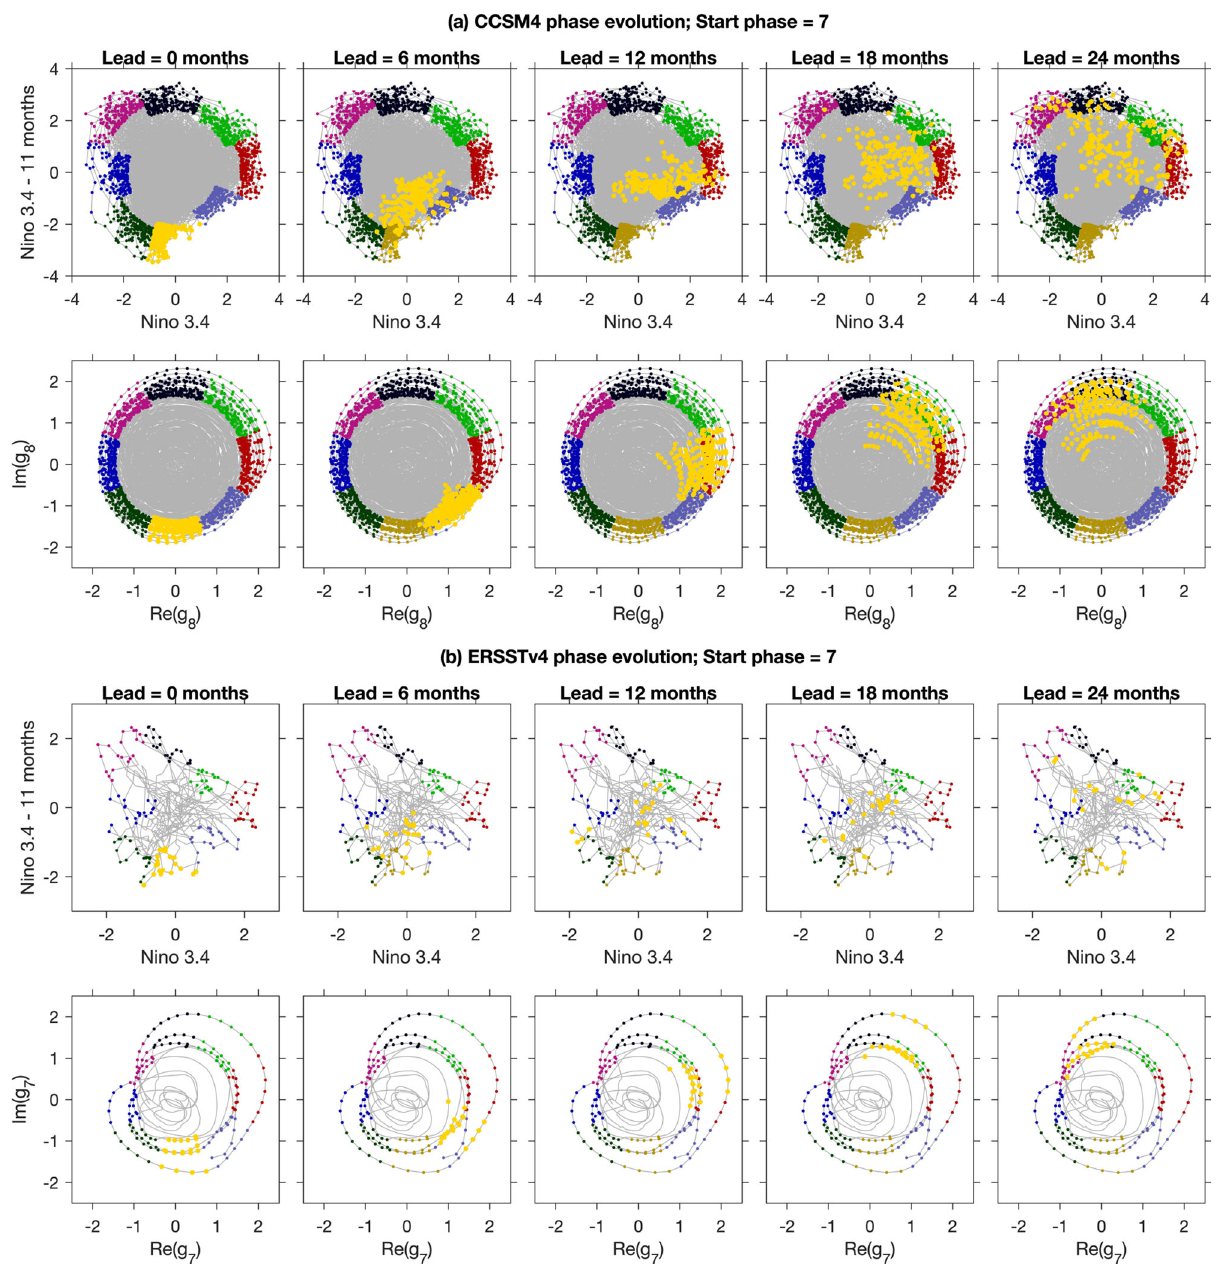
Fig. 9 Evolution of ENSO Phase 7 at six-month increments for CCSM4 (a) and ERSSTv4 (b). Evolution of ENSO Phase 7 at six-month increments for a CCSM4 and b ERSSTv4. In each set of panels, the top and bottom rows depict the phase evolution associated with the lagged Niño 3.4 indices f nino and generator eigenfunctions g j , respectively. Bold yellow dots show the Phase 7 members (left column) and their forward images (right four columns) under the dynamics. Dots colored in muted colors show the phase partitioning from Fig. 6 for reference. Observe that the generator-based evolution undergoes a uniform phase progression with signi fi cantly smaller spread than the Niño-based